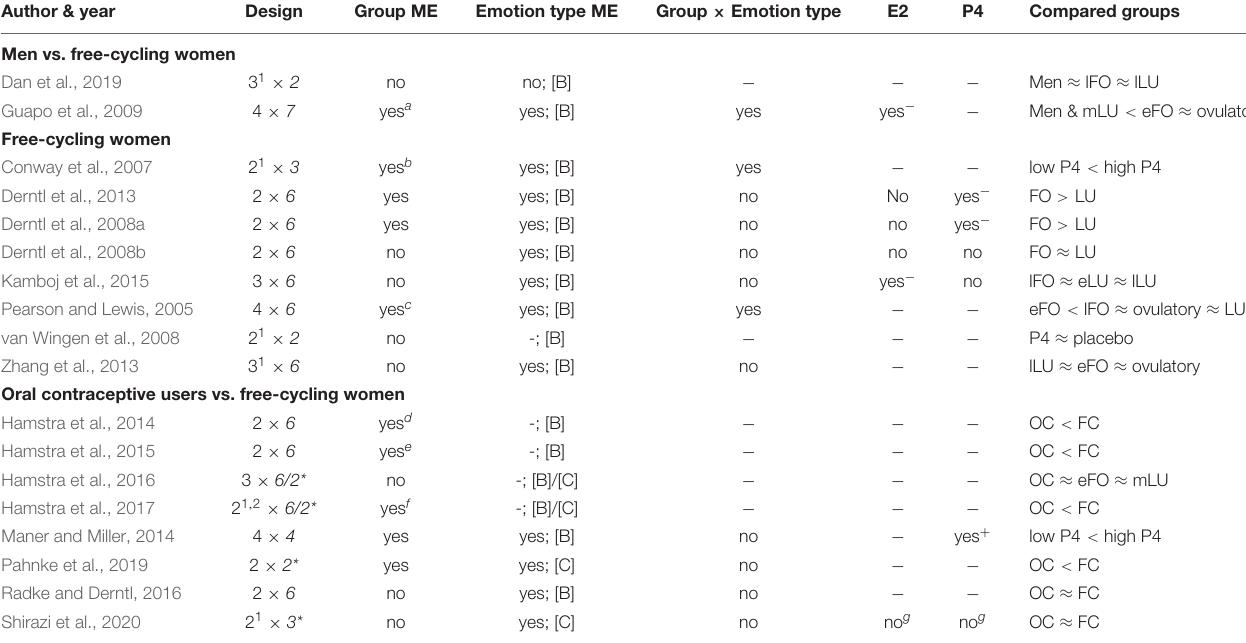
TABLE 1 | Emotion recognition in hormone-status groups: Design and